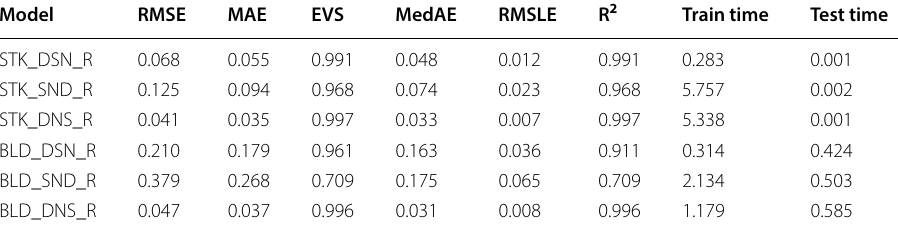
Table 25 Stacking and blending ensemble regressors error metrics result on JSE dataset